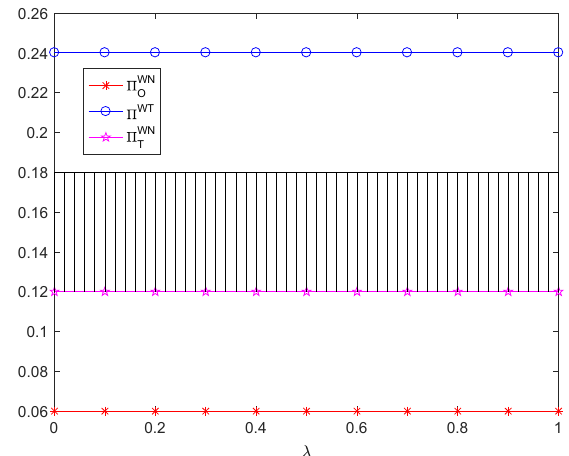
Figure 6. The range of fixed payments without blockchain technology.